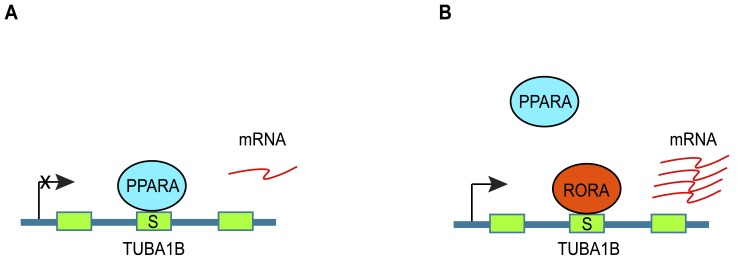
Competition model for PPARA and RORA regulation of TUBA1B expression.(A) TUBA1B expression is repressed by binding of PPARA to putative element S5. (B) TUBA1B gene expression is activated by displacement of PPARA from S5 by RORA.